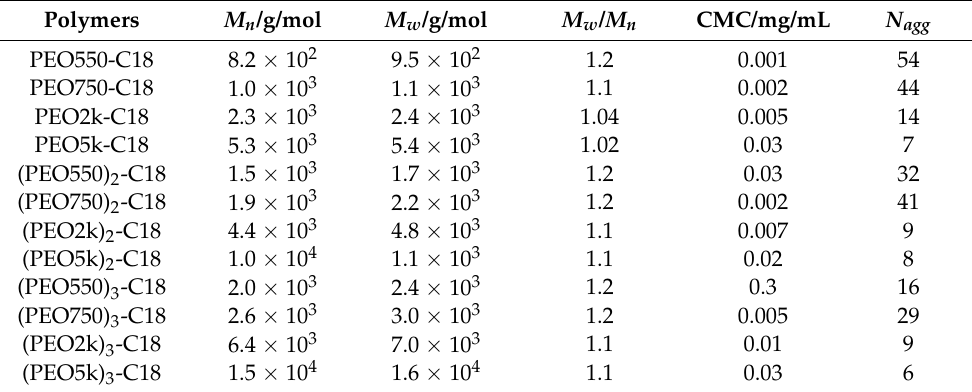
Table 1. Molecular weight, CMC and aggregation number ( N agg ) of micelles of (PEO x ) y -C18s.